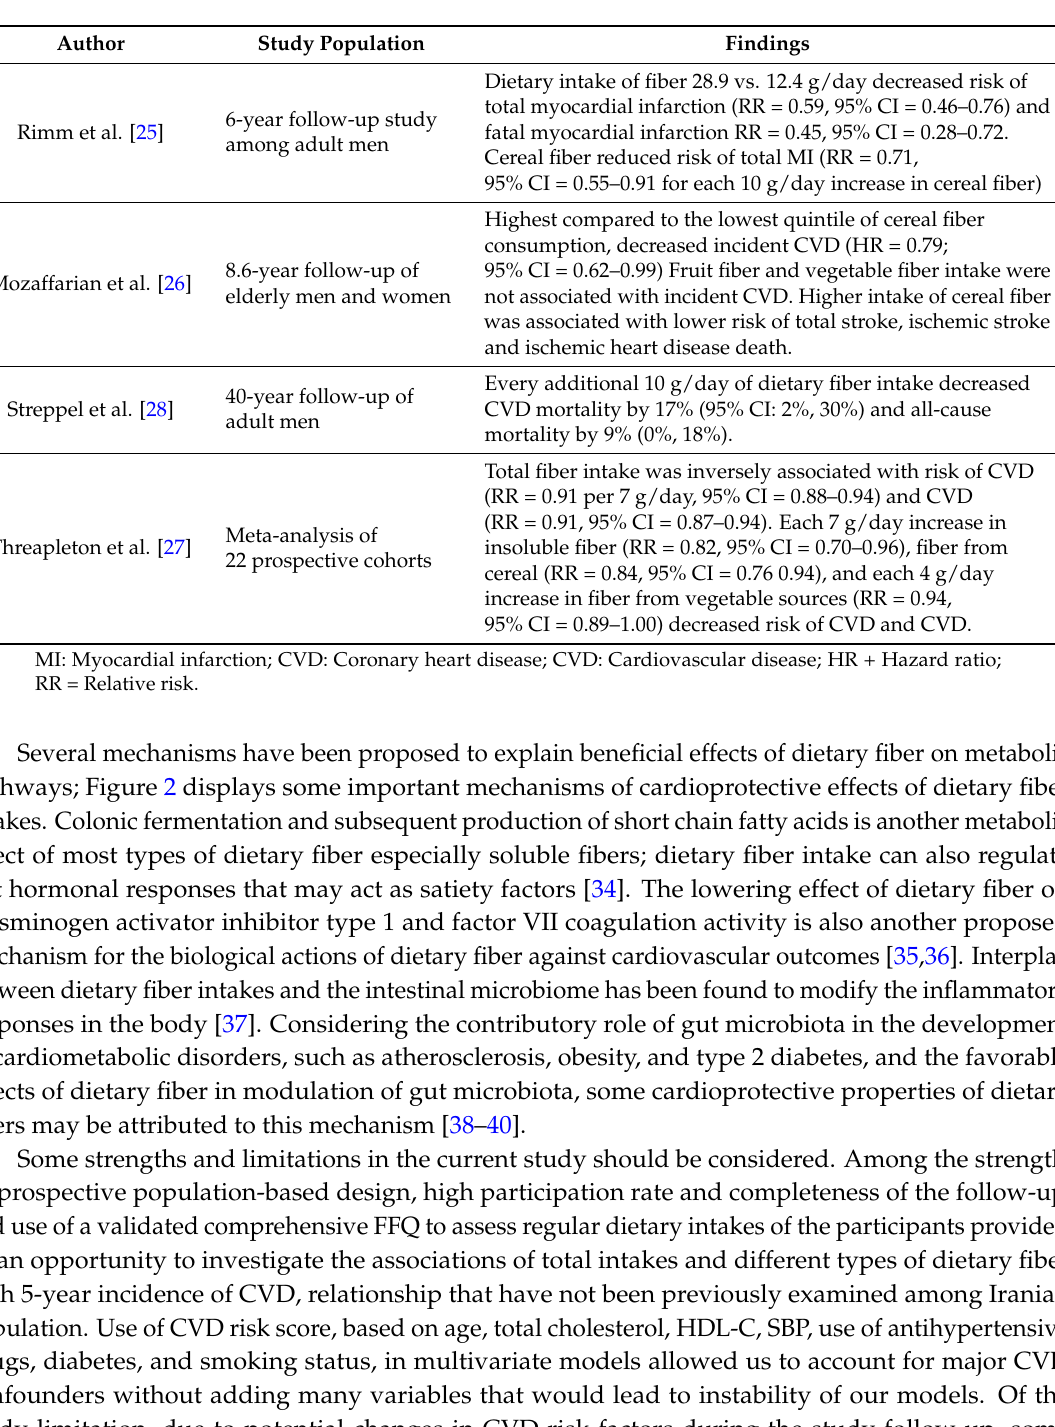
Table 4. The association of dietary fiber intakes and the risk of cardiovascular